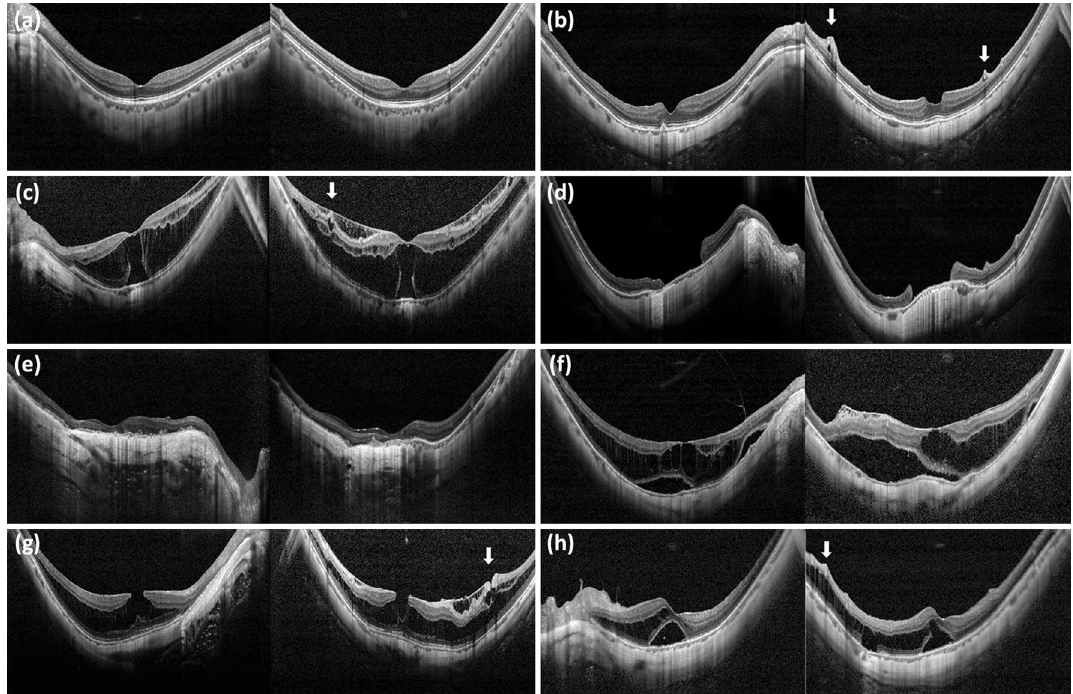
Figure 2. Various high myopia related features included in this study. Left column is horizontal section and right column is vertical section. ( a ) Severe curvature of posterior pole. ( b ) Paravascular retinal cysts and vascular microfolds (arrows). ( c ) Foveoschisis and impending macular hole was shown. Paravascular retinal cyst is also shown (arrow). ( d ) Macular hole and dome shape macula. ( e ) Macular chorioretinal atrophy. ( f ) Retinal detachment and retinoschisis. ( g ) Foveoshcisis and paravascular lamellar hole with retinal cysts (arrow). ( h ) Retinoschisis (arrows) with vascular microfolds and retinal detachment.